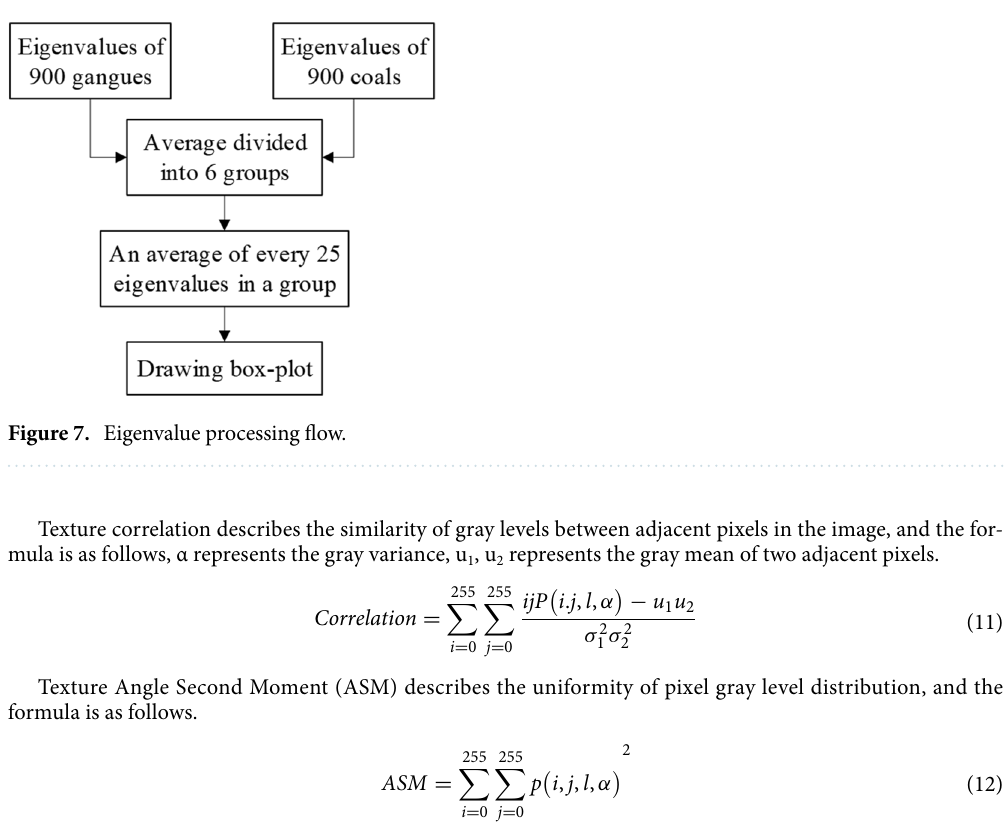
Grayscale features. The differences between coal and gangue in various gray and texture features were